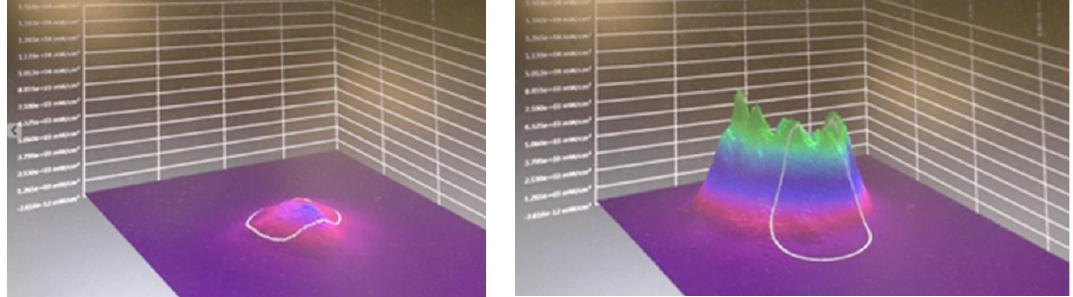
Figure 5. Three-dimensional render of optical beam profile: transillumination through a 2 mm sample of porcine tissue. On the left : 810 nm 0.28 cm 2 spot size, 190 mW (0.5 J / cm 2 ). On the right : 810 nm 1 cm 2 spot size, 500 mW (0.5 J / cm 2 ).